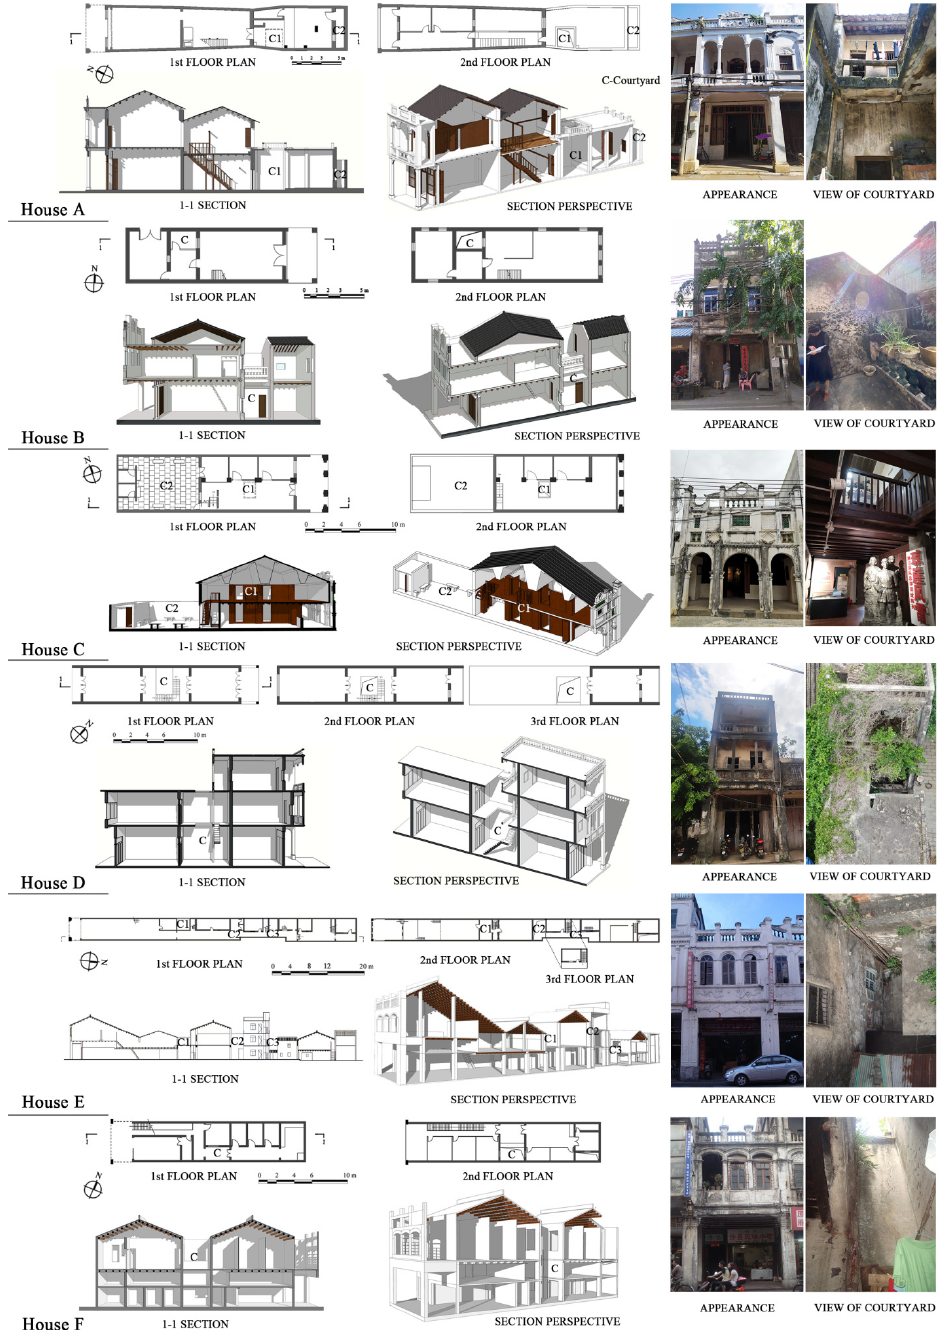
Figure 5. Representative selected vernacular houses.